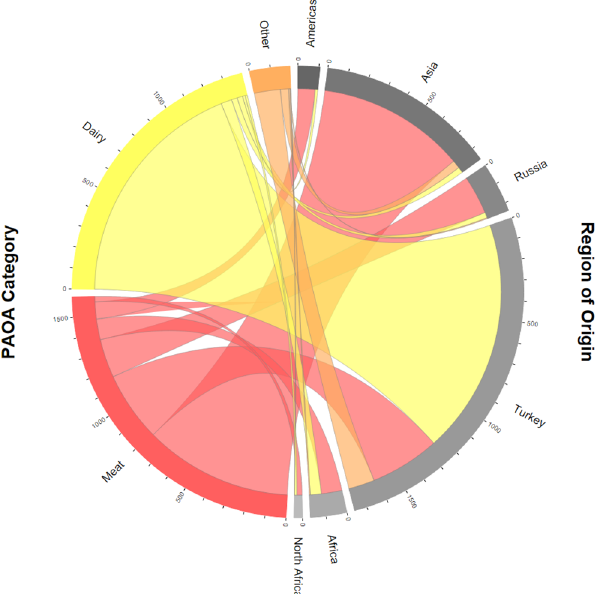
Fig 5. Seized meat products, dairy products, and other POAO in kilogrammes at IA 2 in 2014 according to region of origin. Arc lengths on the outer circle are proportional to the fractions of POAO categories and regions of origin,